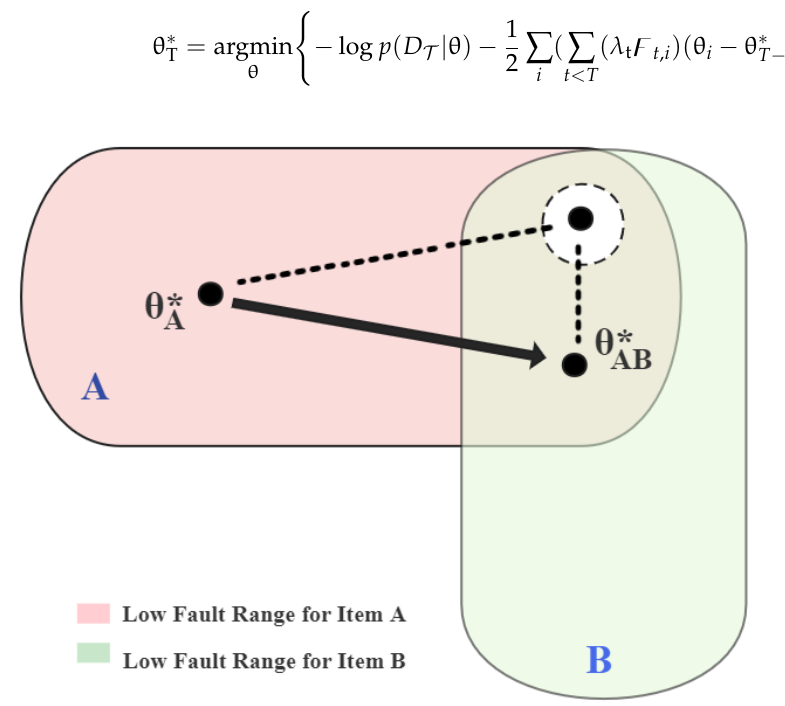
Figure 2. Search space for Elastic Weight Consolidation strategies.